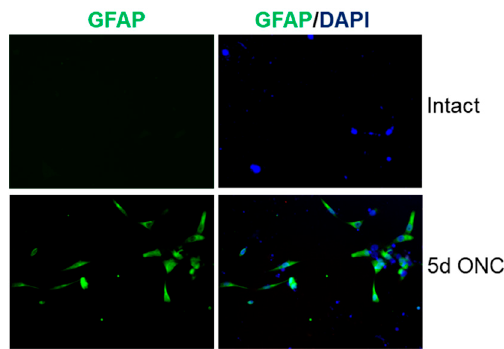
Figure 3. GFAP immunoreactivity in retinal cultures prepared from intact adult rats and at 5 days after ONC. Few, if any, GFAP + glia were present in cultures from intact rats whereas lots of GFAP + glia were present in cultures prepared from rats at five days after